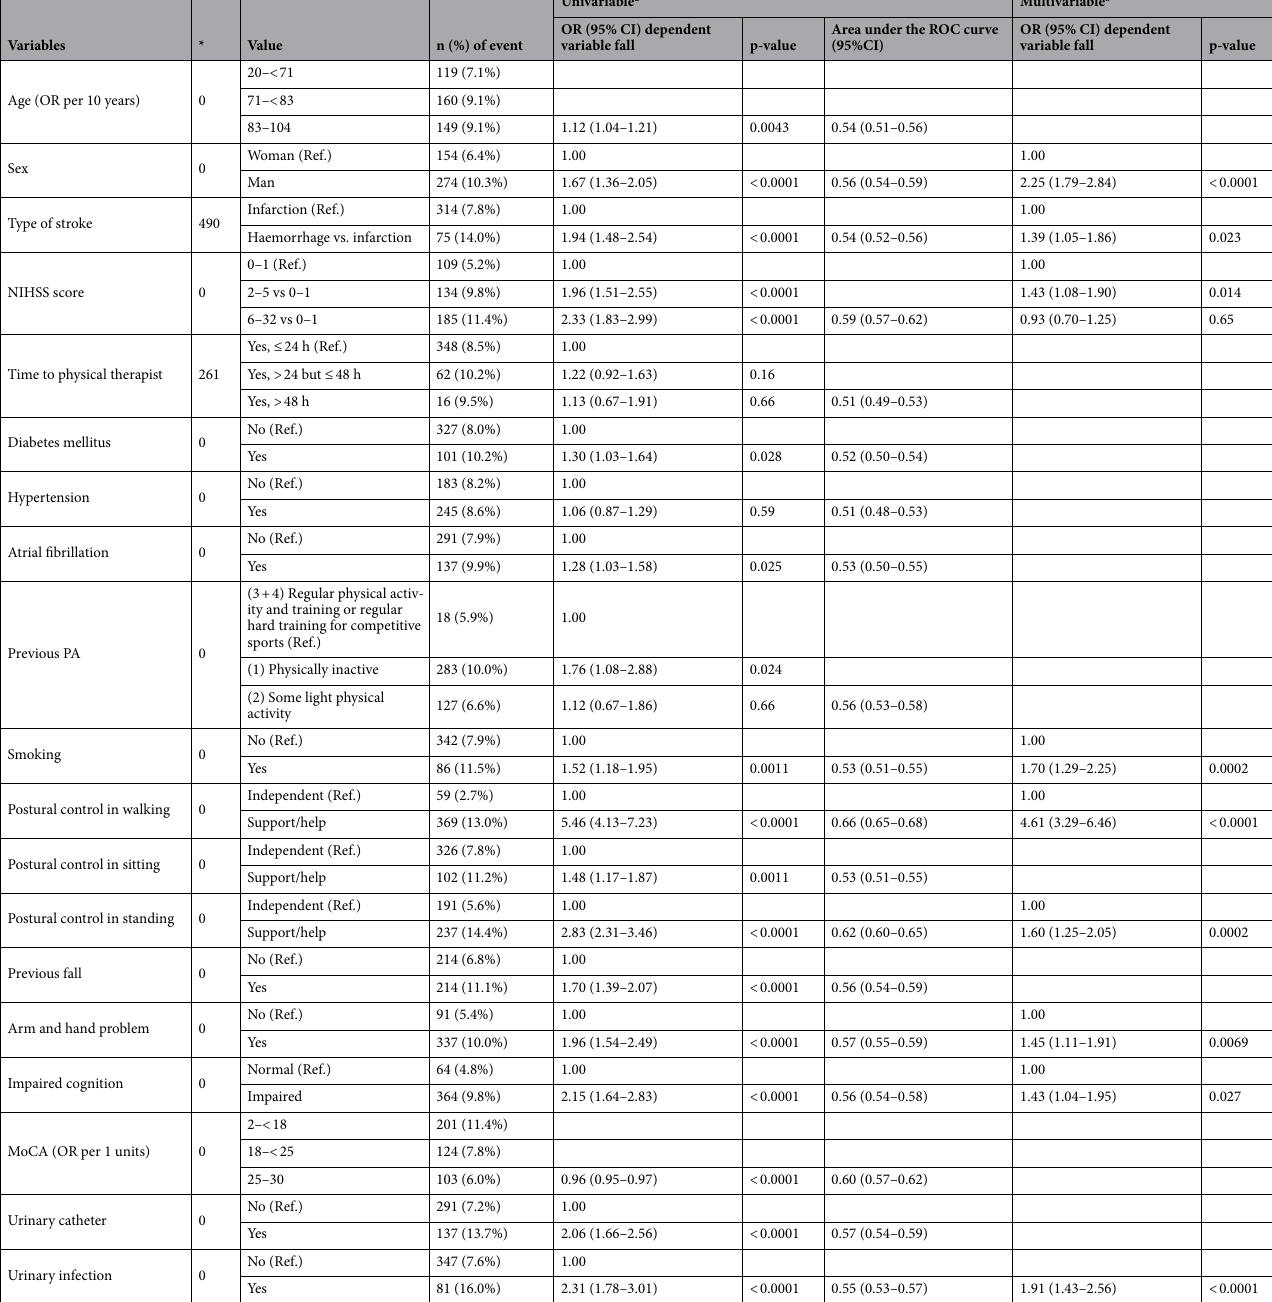
Table 2. Univariable and multivariable logistic regression for incidence of falling during hospital stay in 5065 patients with stroke (imputed data). There was no imputation for the 490 individuals who did not have data on the type of stroke. Area under ROC curve with 95% CI for multivariable model = 0.76 (95% CI 0.73–0.78). The Hosmer and Lemeshow test was non-significant (p = 0.50). OR indicates odds ratio; 95% CI: 95% confidence interval; ROC: receiver operating characteristic; previous physical activity category 3 + 4 indicates regular physical activity and training or regular hard physical training for competitive sports; category 2: some light physical activity; category 1: physical inactivity; MoCA: the Montreal Cognitive Assessment scale. p-values, OR and Area under ROC curve are based on original values and not on stratified groups. OR is the ratio for the odds of an increase in the predictor of one unit. For categorical variable groups, each group is compared with the rest. a All tests are performed with univariable logistic regression. b Multivariable logistic regression models are based on 4575 individuals and include: postural control when walking 10 m indoors; sex; urinary infection; postural control in standing; smoking (one or more cig./day or quit last 3 months); NIHSS group; stroke-related arm and hand problem; type of stroke (grouped) and cognition (MoCA) (grouped). *The number of missing data before the imputation of missing